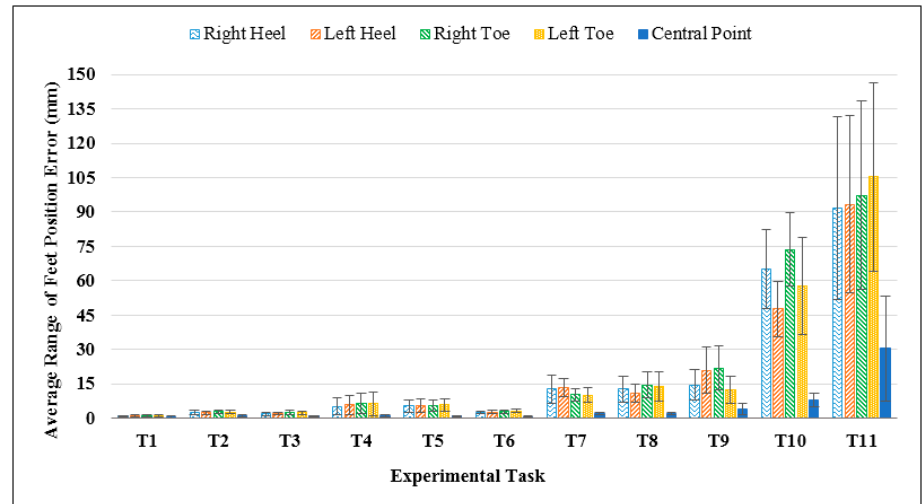
Figure 10. Average range of position errors of Xsens-based BOS in different experimental tasks.